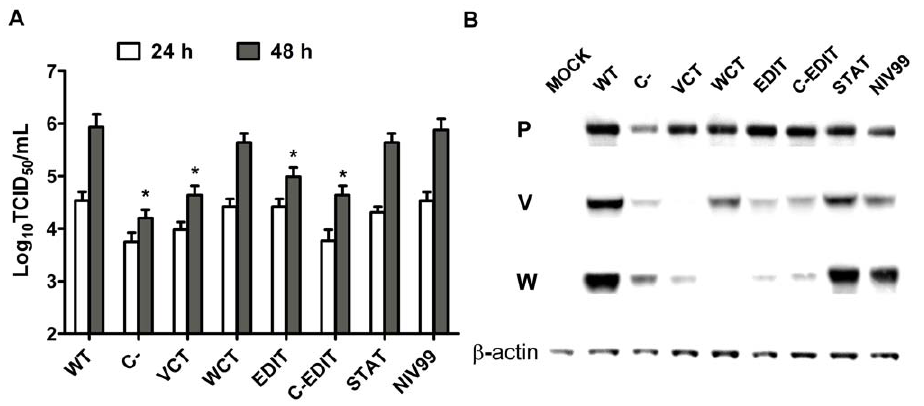
Figure 3. Characterization of recombinant NiVs in HMVEC-L cells. ( A ) Comparative viral growth curves. HMVEC-L cells were infected with each indicated recombinant NiV in triplicate wells at an MOI=2 for 2 h before inoculum was removed and replenished with fresh media. At the time points indicated, infected cell supernatants were serially diluted before being used to infect Vero cells to calculate Log 10 TCID 50 /mL. Error bars indicate one standard deviation of the mean of triplicate infections. ANOVA with Dunnett’s multiple comparison test was used to measure the statistical significance of differences in peak viral titer at 48 hours PI when compared with WT recombinant virus. * p , 0.001. ( B ) Western blot analysis of P gene products from infected HMVEC-L cell lysates. HMVEC-L cells were infected with each indicated recombinant NiV at an MOI=2 for 2 h before inoculum was replaced with fresh media. At 24 h PI, infected cell lysates were harvested in NET-BSA buffer and run on a 4–12% Bis-Tris SDS gel. Proteins were transferred onto PVDF membranes, blocked in 5% milk with TBS-T, and probed with mouse antipeptide sera against indicated proteins. NiV C protein could not be detected.